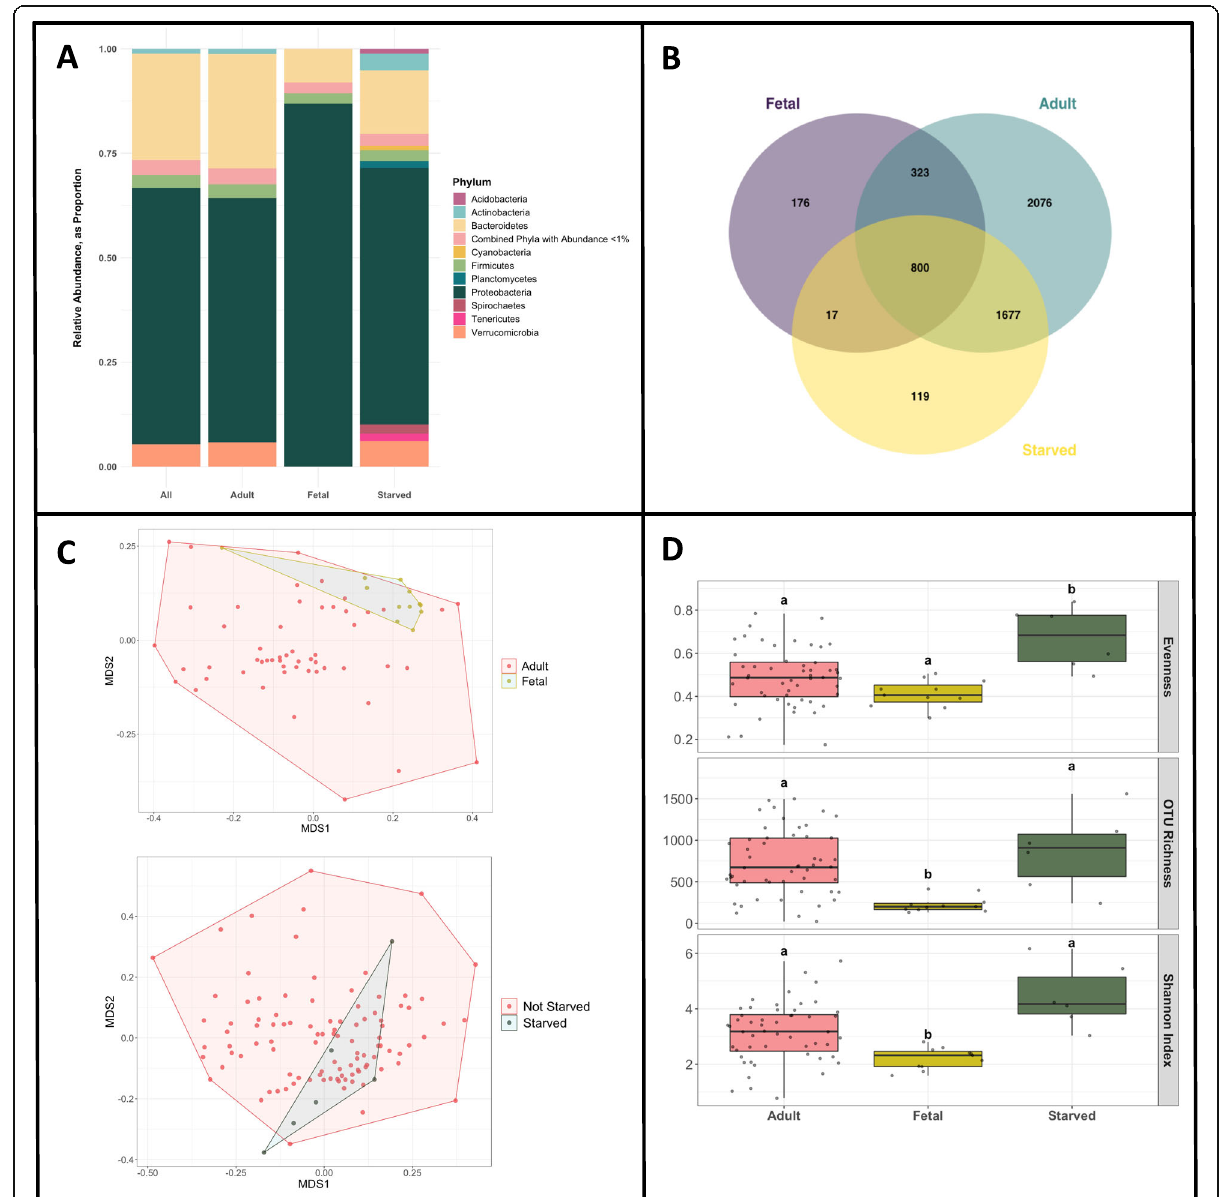
Fig. 2 A Relative abundance of bacterial phyla contributing at least 1% in each snail sample set. B Three-way Venn diagram of the microbial OTU composition in the guts of members of O. strigosa from adult, fetal, and starved groups. C Non-metric multi-dimensional dimensional scaling analyses for (upper) adult vs. fetal samples (PERMANOVA: p -value < 0.001, R 2 -value = 0.095) and (lower) starved vs. non-starved samples (PERM ANOVA: p -value < 0.002, R 2 -value = 0.038). D Diversity boxplots showing differences in species richness, species evenness, and Shannon Index of adult, fetal, and starved groups. Jitter shows distribution of samples. Letters above bars indicate significant